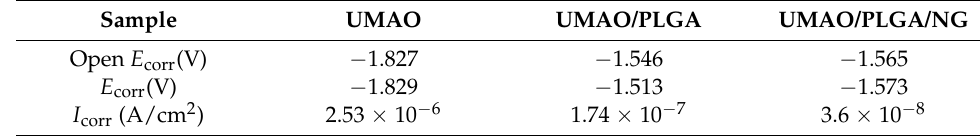
Figure 6. Polarization curves of different coatings. Table 3. Corrosion current densities and corrosion potentials for different